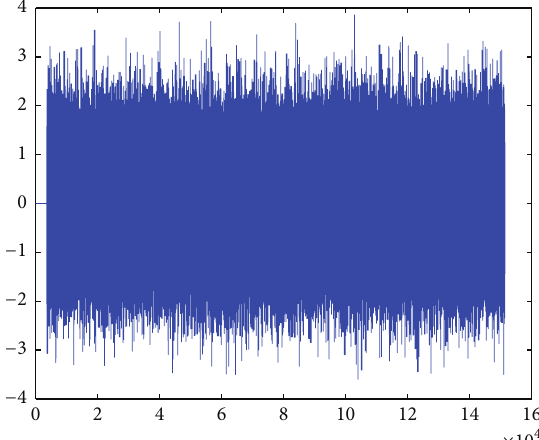
Figure 7: Temporal waveform of the original QPSK OFDM